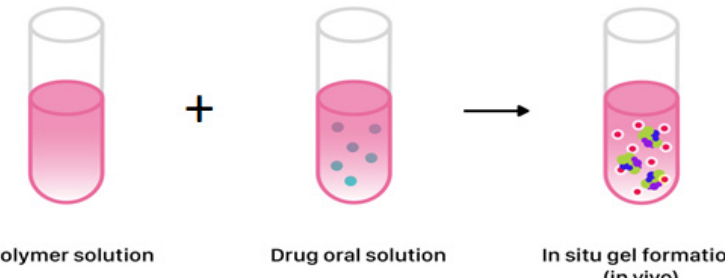
Figure 5. In situ gel formation from liquid for obtaining sustained or controlled release profile of drug in liquid dosage form.